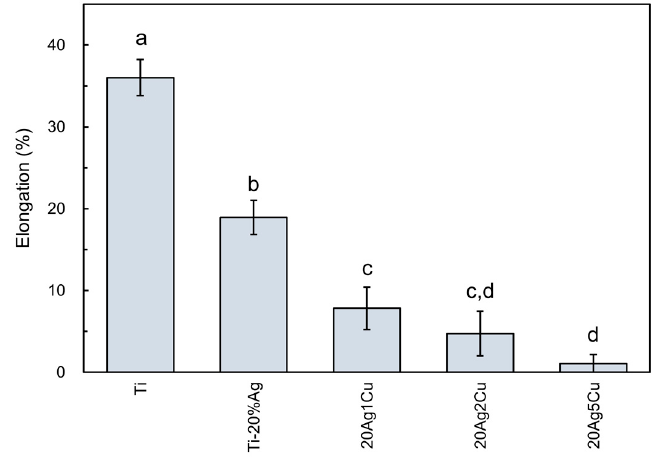
Figure 6. Elongation of Ti-Ag-Cu alloys. Identical letters indicate a statistically insignificant difference ( p > 0.05).